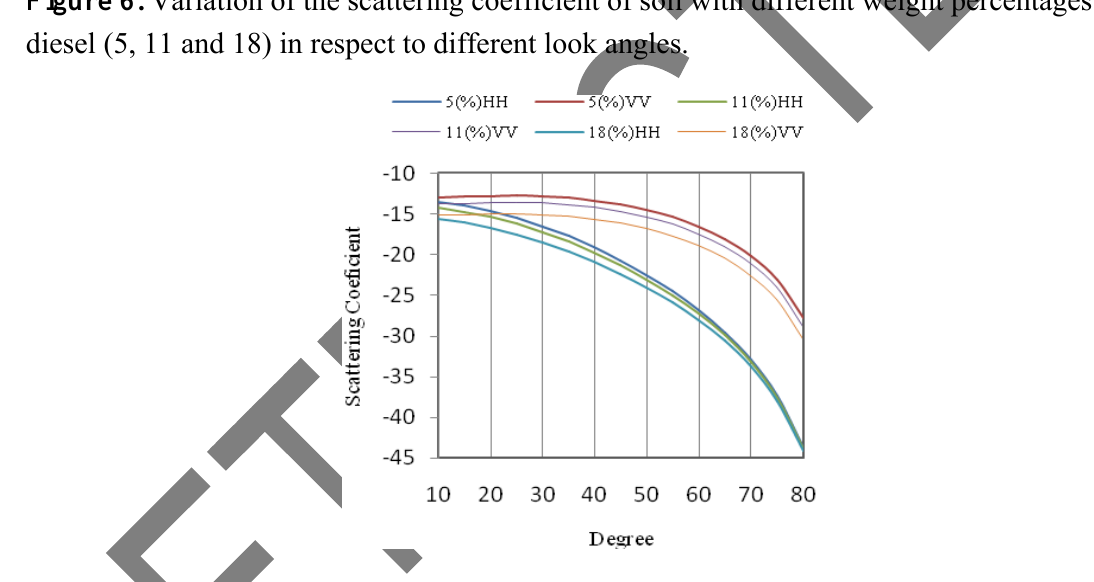
Figure 7. Variation of the scattering coefficient of soil with different weight percentages of diesel (6, 10 and 17) in respect to different look